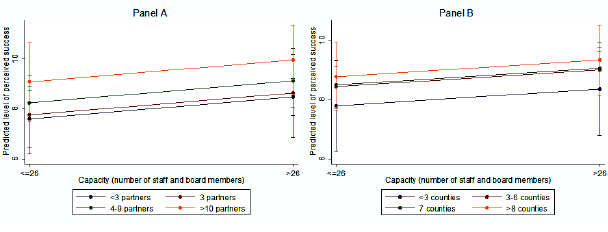
Fig. 3 . Effect of land trust partnerships (panel A) and scale of operation (panel B) on perceptions of success, by organizational capacity. Bars represent 95% confidence intervals for the predicted values of perceived